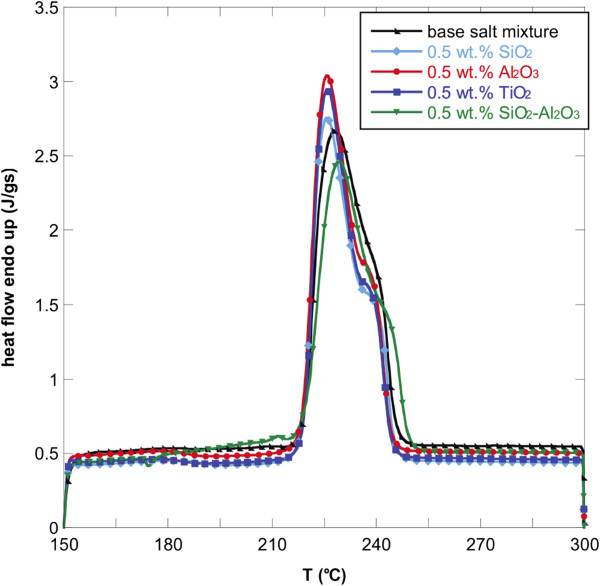
Heat flow versus temperature for NaNO3-KNO3 binary salt mixture and nanofluids (0.5 wt.% of oxide nanoparticles).